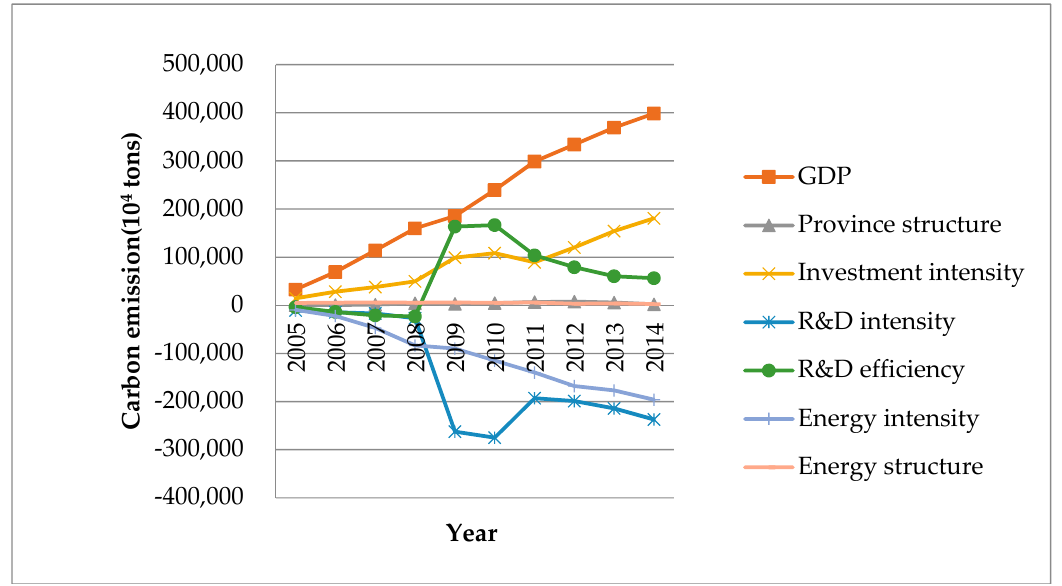
Figure 7 . The accumulated effect of different factors of carbon emissions from energy consumption of China in 2005–2014.